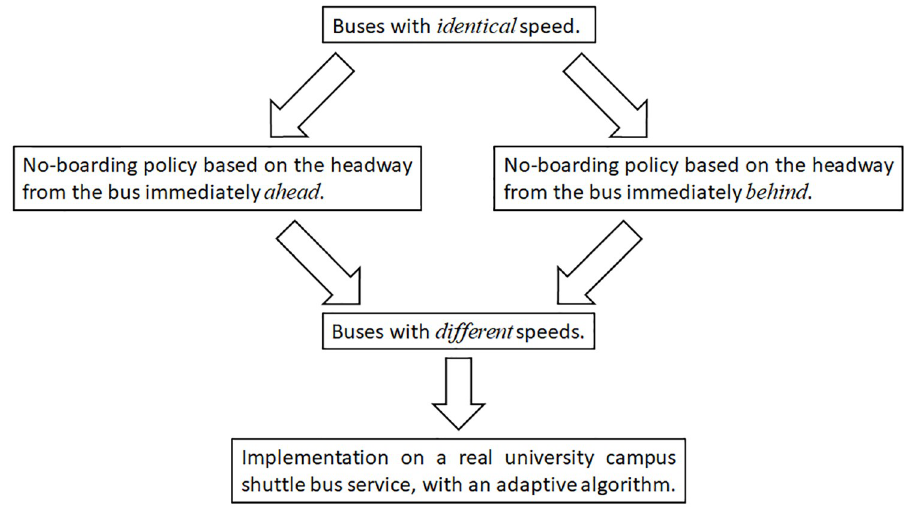
Fig 1. Outline and organisation of this